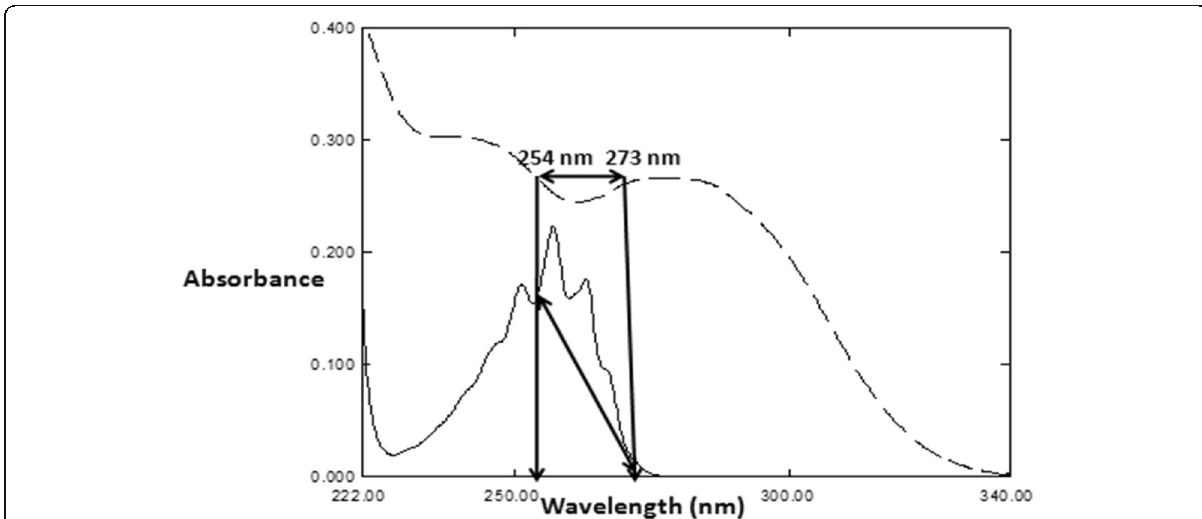
Fig. 3 Zero-order absorption spectra of PSE (s/b d) 240.0 μ g/mL and LOR (s/b e) 10.0 μ g/mL showing absorbance difference at 254 nm and 273